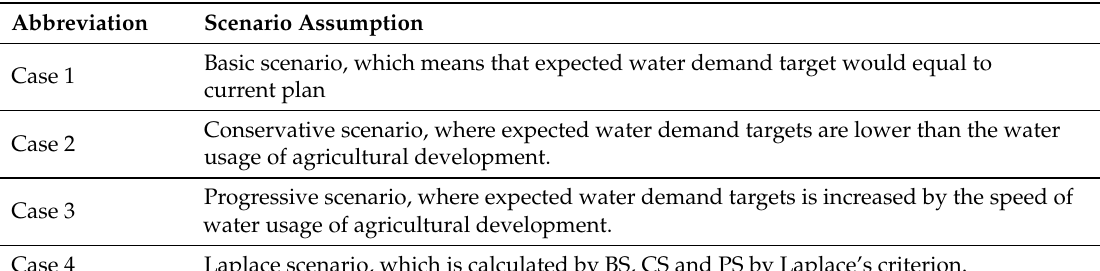
Table 3. List of